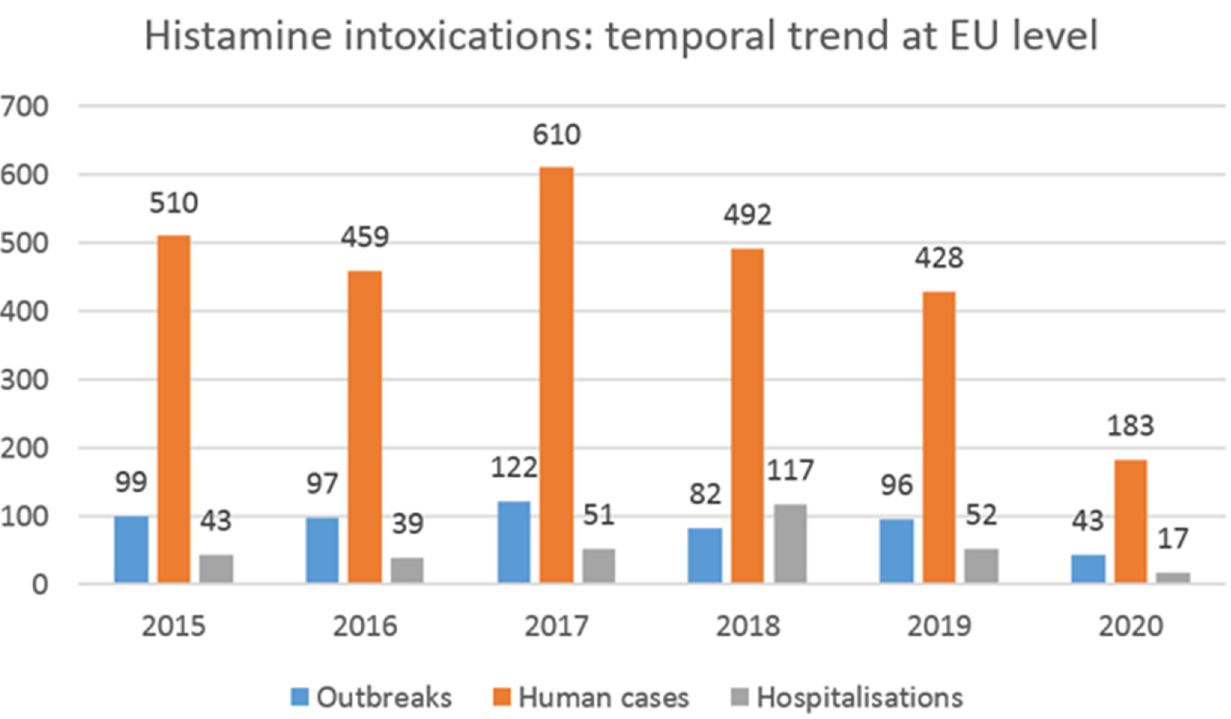
Figure 5. Number of foodborne outbreaks, human cases, and hospitalizations caused by histamine and scombrotoxin in reporting EU member states over the 2015–2020 period (data from EFSA foodborne outbreaks dashboard).